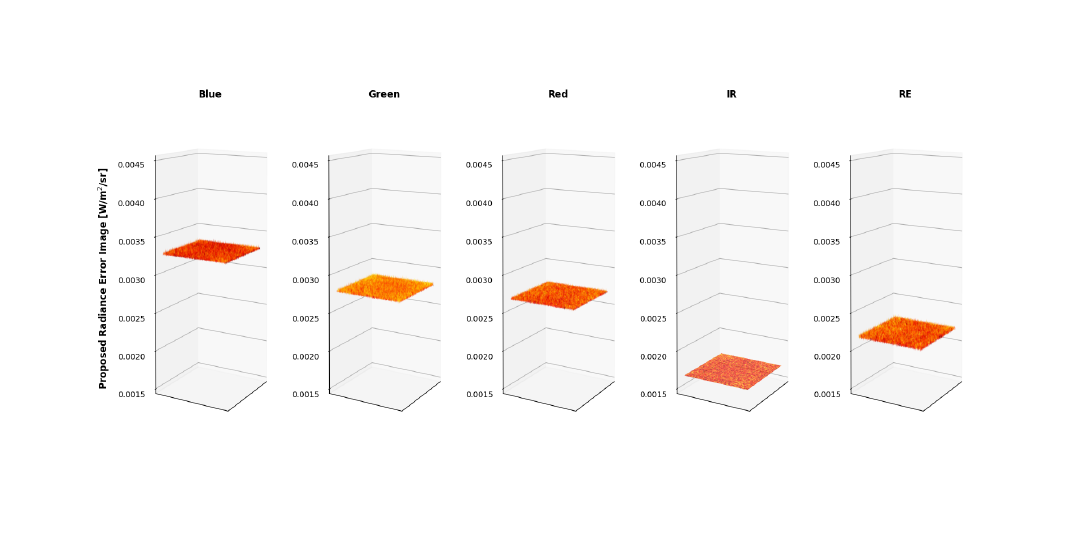
Figure 26. Error of proposed radiance imagery. Gain, exposure time, image and radiometric calibration coefficient error components are present. Error images are all flat for all channels, as the radiance images were. Table 12. Percentage error in radiance of the radiance image. IR and RedEdge produced higher radiance errors under the MicaSense methodology. Method Blue Green Red IR RedEdge MicaSense 3.85